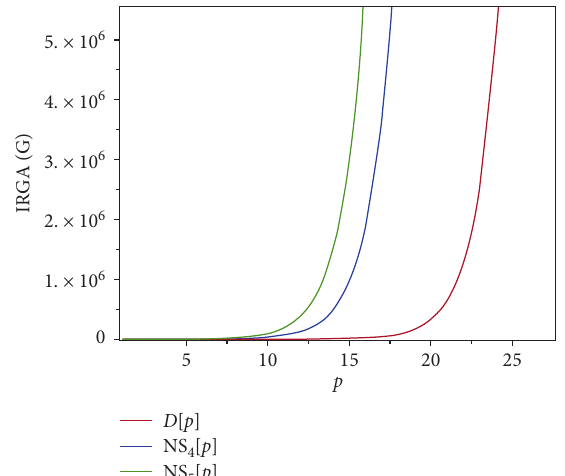
Figure 8: Curves of irregularity index IRGA.